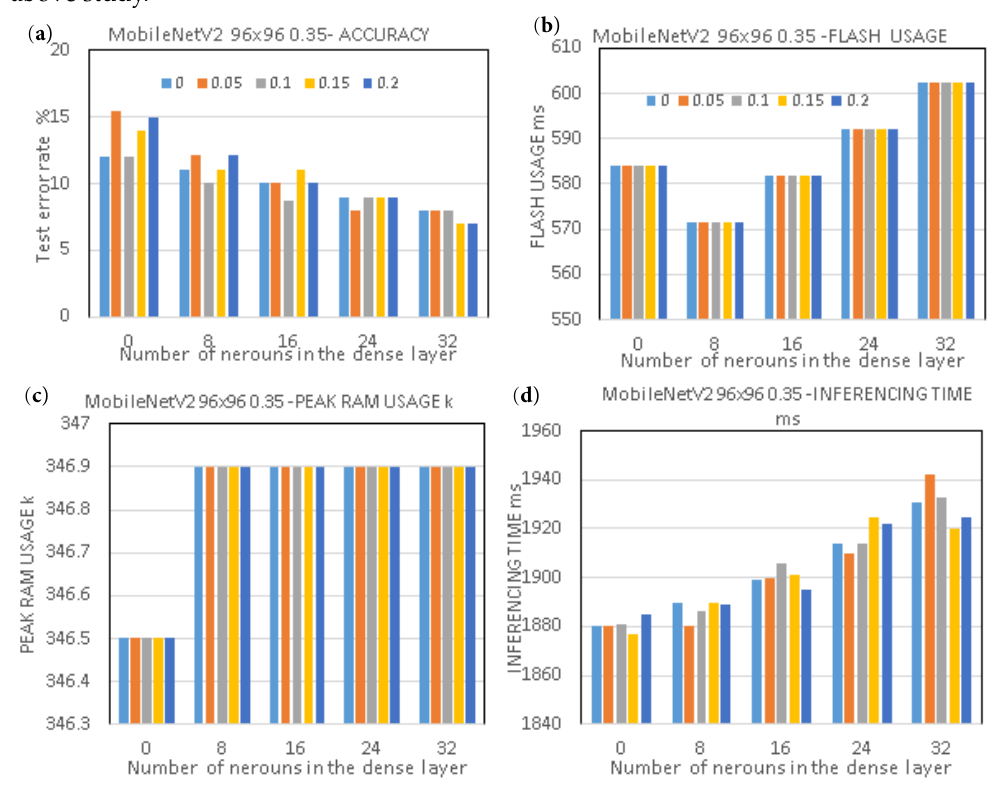
Figure 5. Effect of the number of neurons in the dense layer on model accuracy, Flash usage, peak RAM usage, and model inference time.